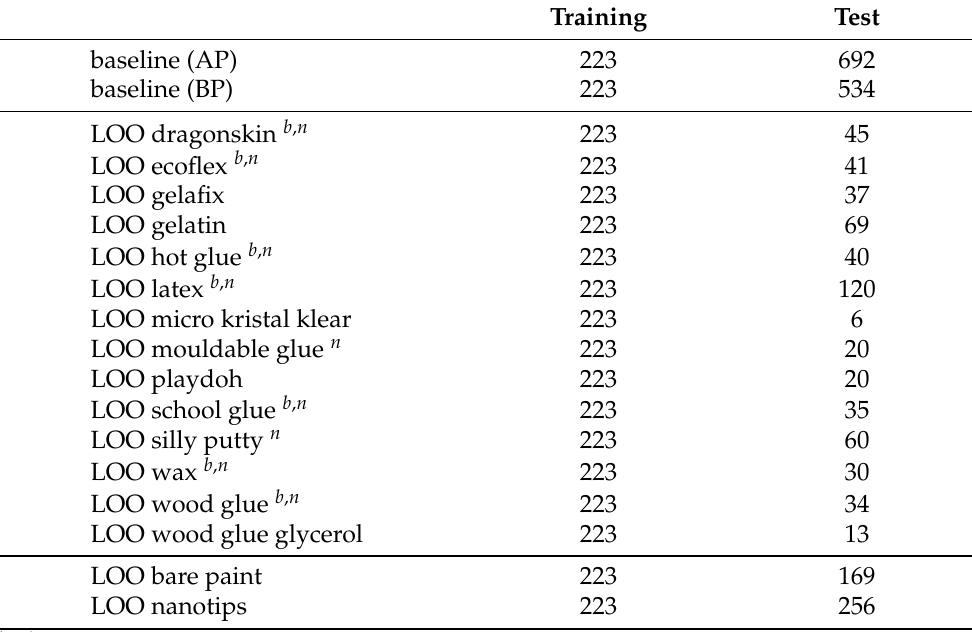
Table 4. Numbers of samples per dataset partition. The same BPs of the baseline partition were used in all LOO